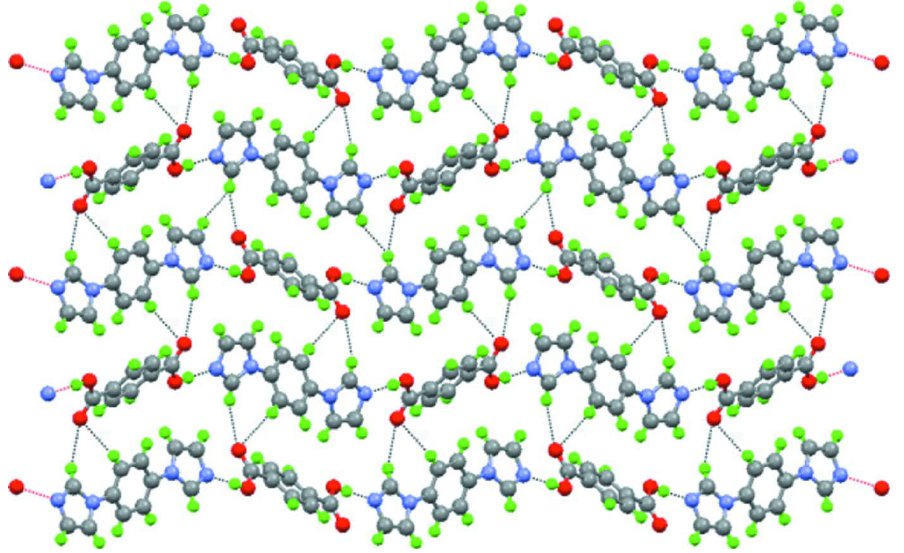
Figure 2 A two-dimensional network layer of the title compound viewed along the c axis. Dashed lines indicate O—H···N and C— H···O hydrogen bonds. C, gray; H, green; O, red; N,